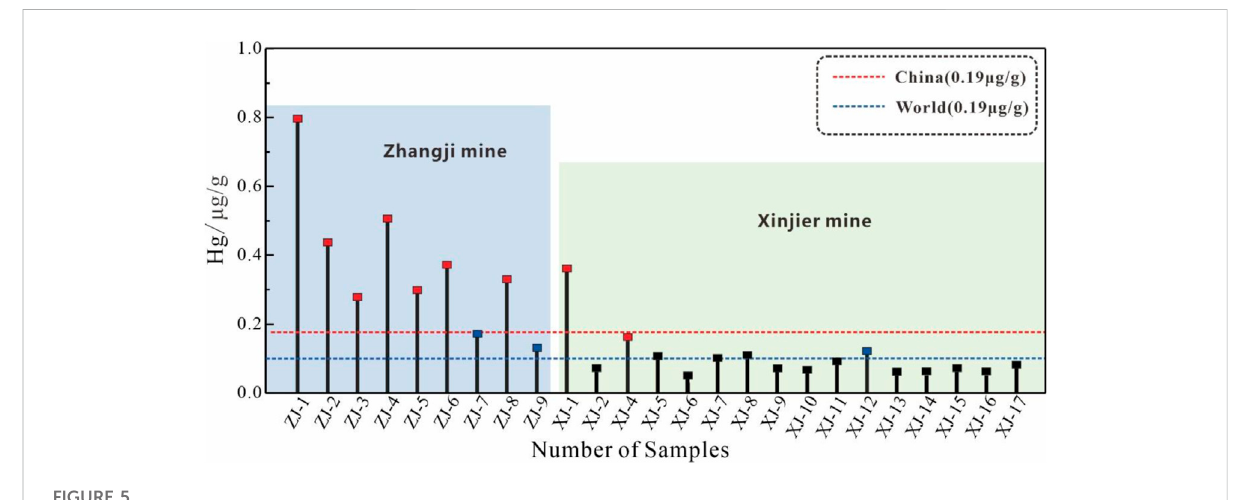
FIGURE 5 Mercury content distribution in coal of Huainan Shanxi